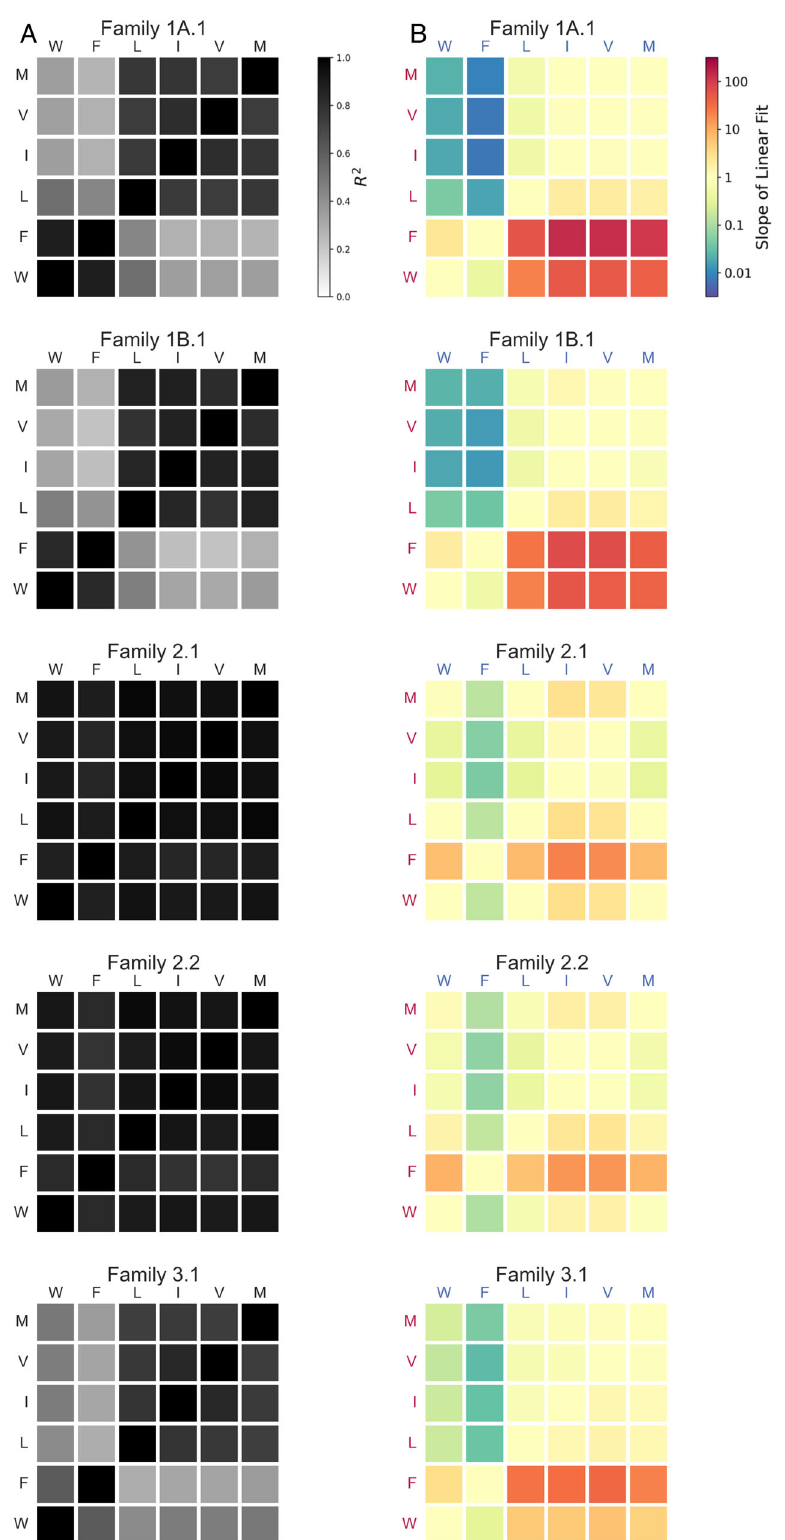
Fig. 3 Substrate preferences and correlations of activity. A Heat maps of coef fi cient of determination (R 2 ) for pairwise comparisons in Fig. 2. B Heat maps for slopes of linear regression fi ts for pairwise comparisons in Fig. 2. Slope > 1 indicates a preference for the substrate on the y-axis; slope < 1 indicates a preference for the substrate on the x-axis. Source data are provided as a Source Data fi